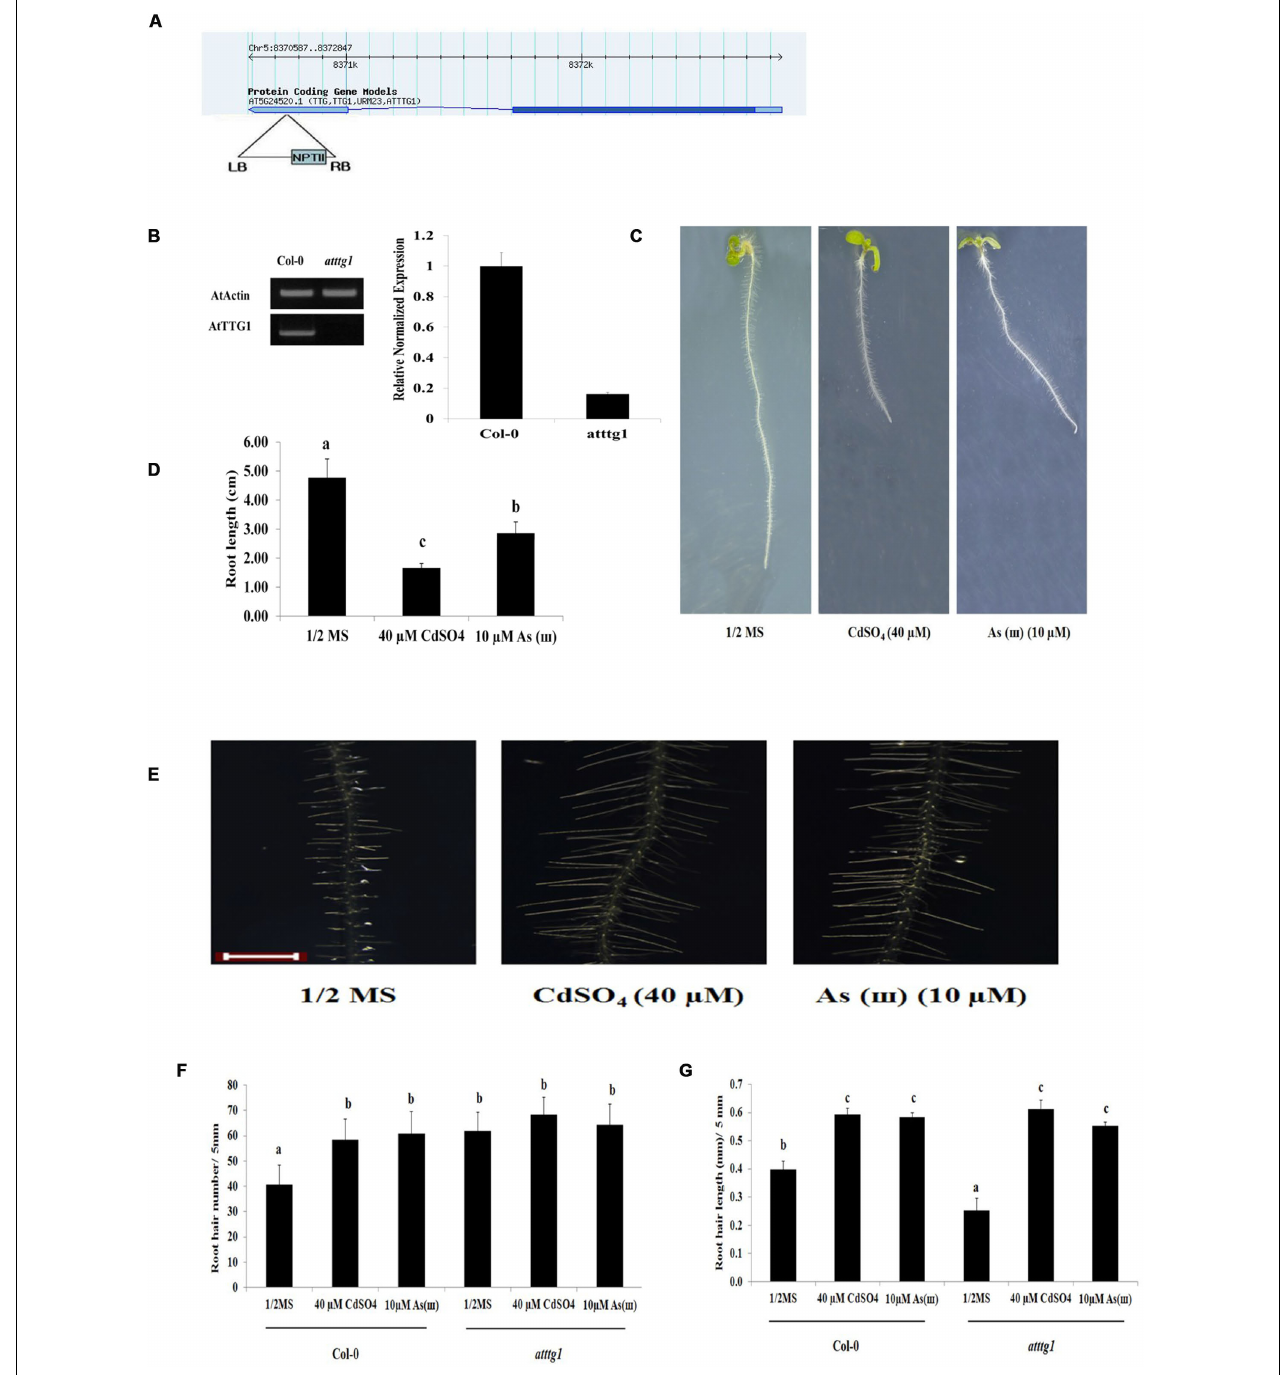
FIGURE 5 | Root hair length and density in response to Cd and As(III) in ttg1 Arabidopsis . (A) Diagram showing T-DNA insertion position in ttg1 Arabidopsis . (B) Left, semi-quantitative RT-PCR products (transcript levels) of AtTTG1 in control ( Col -0) and ttg1 Arabidopsis . PCR product of actin ( AtActin ) was used as a loading control; Right, real-time PCR results. (C) Morphology of ttg1 Arabidopsis (1-week-old) seedlings germinated and grown on 1/2 MS agar plates containing no metal (left), 40 µ M CdSO 4 (center), and 10 µ M AsNaO 2 (right). (D) Quantification of the primary root length of ttg1 Arabidopsis shown in (C) . (E) Root hair morphology of ttg1 Arabidopsis germinated and grown on 1/2 MS with no metal (left), 40 µ M CdSO 4 (center) and 10 µ M As(ø) (right). Roots were observed at 40 × magnification; scale bars = 0.2 mm. (F) Graphs representing root hair density in a 5 mm section from the starting point of differentiation zone in ttg1 Arabidopsis shown in (E) . (G) Graphs representing root hair length in a 5 mm section from the starting point of differentiation zone in ttg1 Arabidopsis shown in (E) . Values are average ( ± SE) of three independent experiments, each involving 10 seedlings. Different letters over each column indicate a significant difference according to Tukey’s multiple comparison test ( p ≤